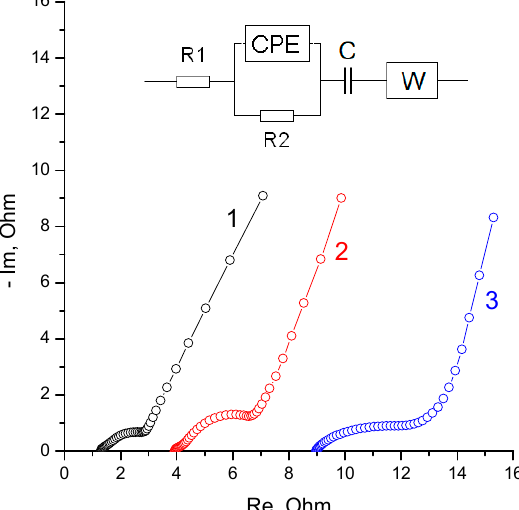
Figure 4. Nyquist diagram and equivalent electrical circuit for the initial state of cells 1, 2 and 3 measured in the frequency range from 100 kHz to 0.01 Hz.